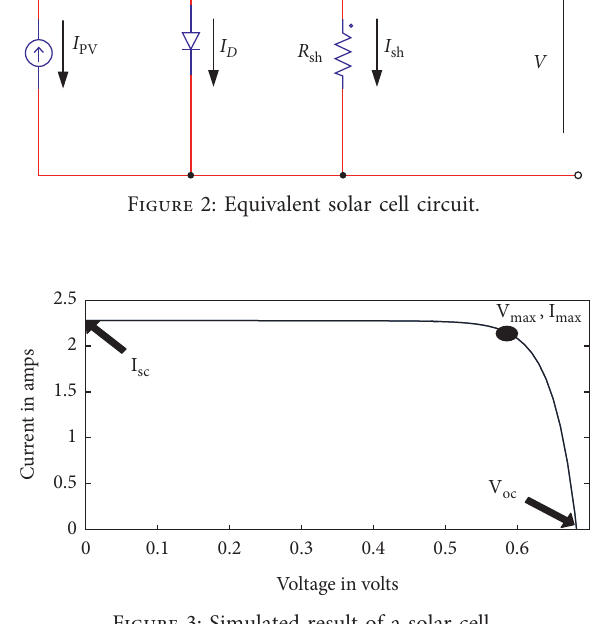
Figure 3: Simulated result of a solar cell.